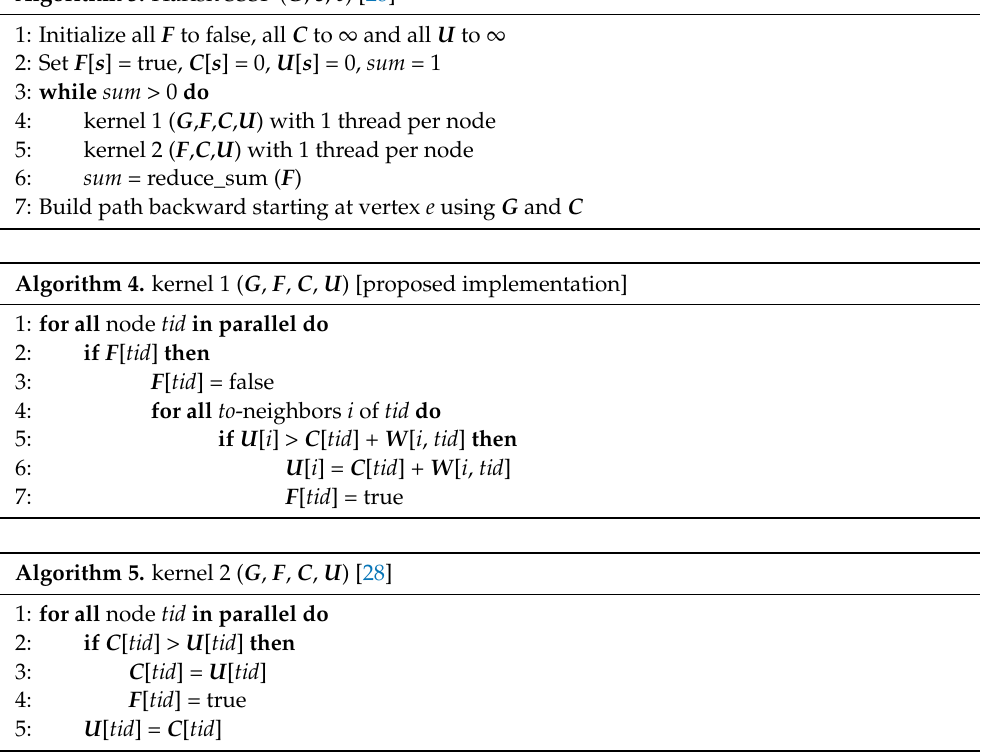
Algorithm 3. Harish SSSP ( G , s , e ) [28]